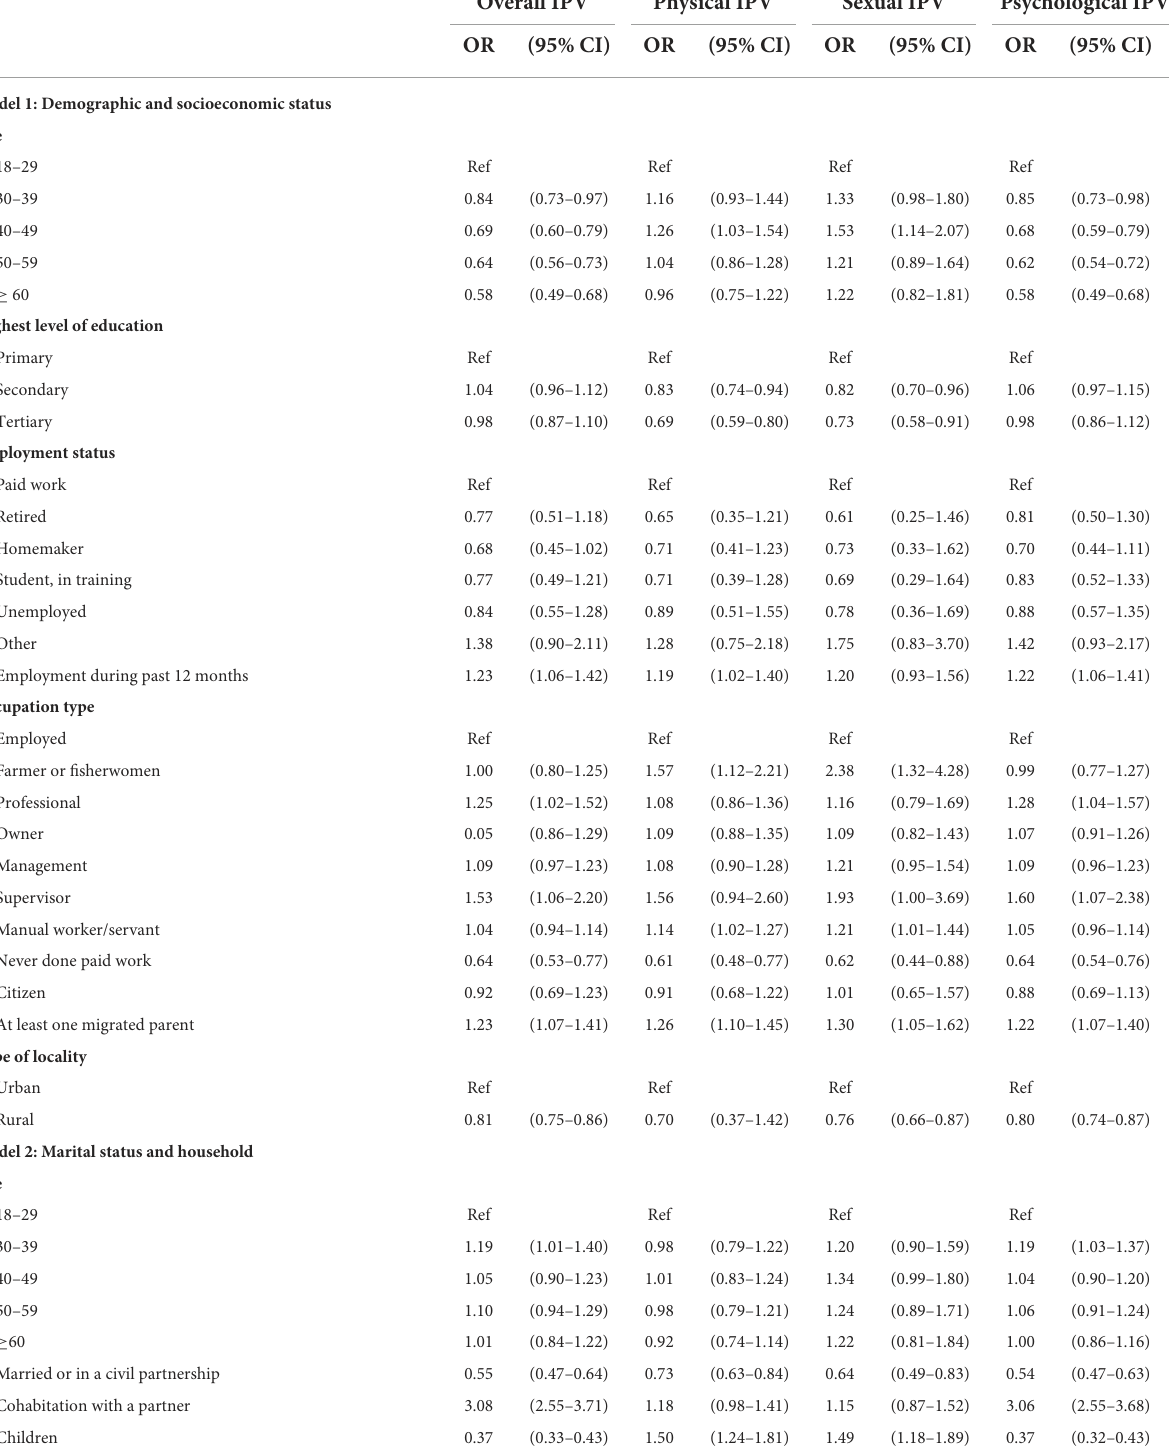
TABLE 5 Associations between overall, physical, sexual, and psychological intimate partner violence (IPV) and ever-partnered women